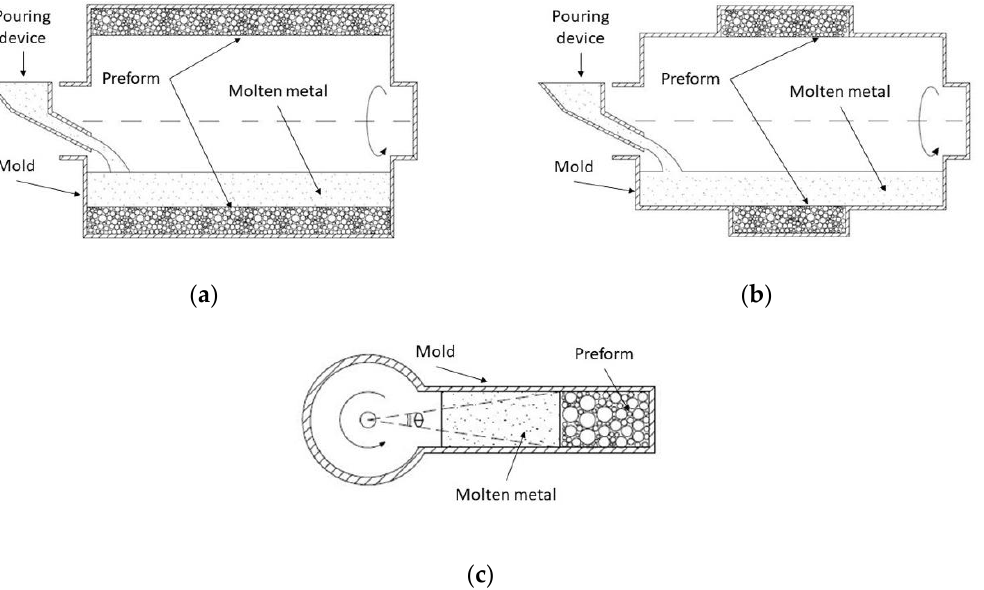
Figure 8. ( a ) Schematic representation of the centrifugal infiltration set-up with pipe preform shape adapted from Nishida et al. [108]; ( b ) Centrifugal infiltration set-up with preform volume, which is very small in comparison to molten metal volume, adapted from Nishida et al. [108]; ( c ) Conventional centrifugal infiltration set-up adapted from Nishida et al. [108].